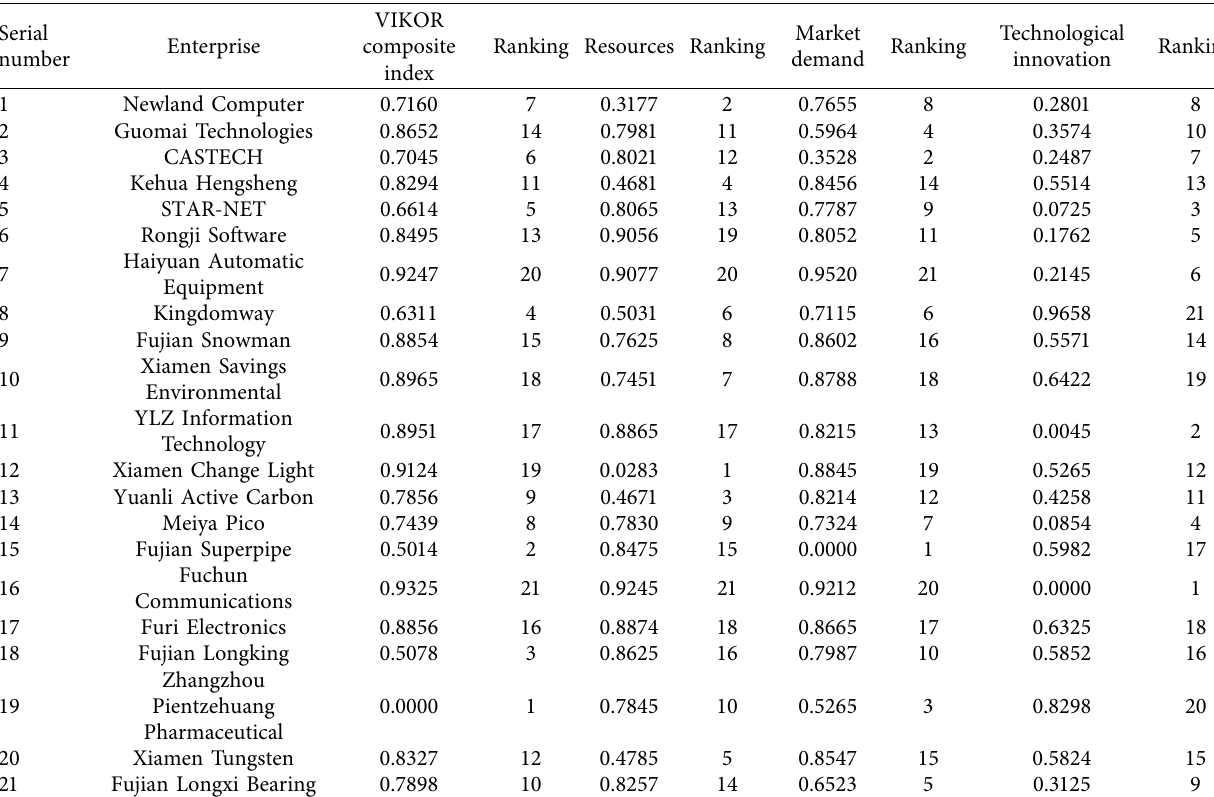
Table 2: VIKOR composite indices of the backbone enterprises